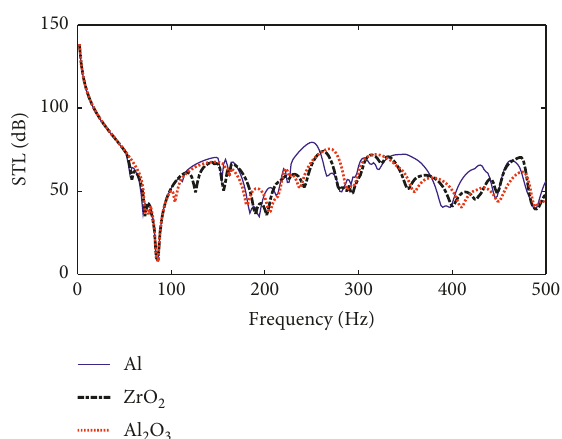
Figure 20: Sound transmission loss of the stiffened double panel- cavity coupled system with different materials of the stiffener.